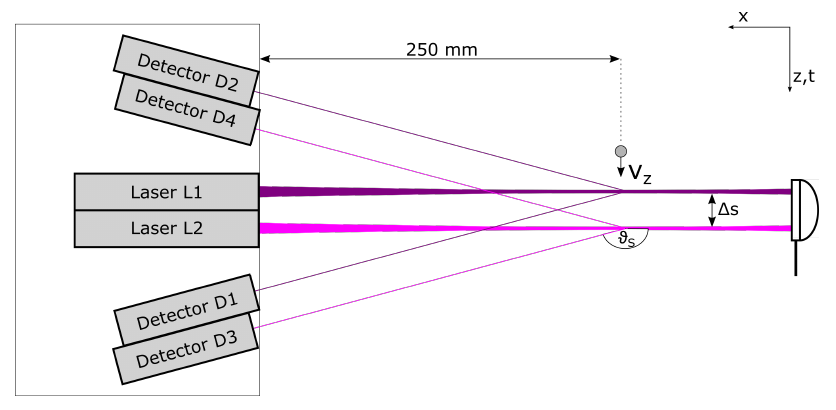
Figure 2. Schematic view of the SpraySpy R (cid:13) system in the x,z-plane.